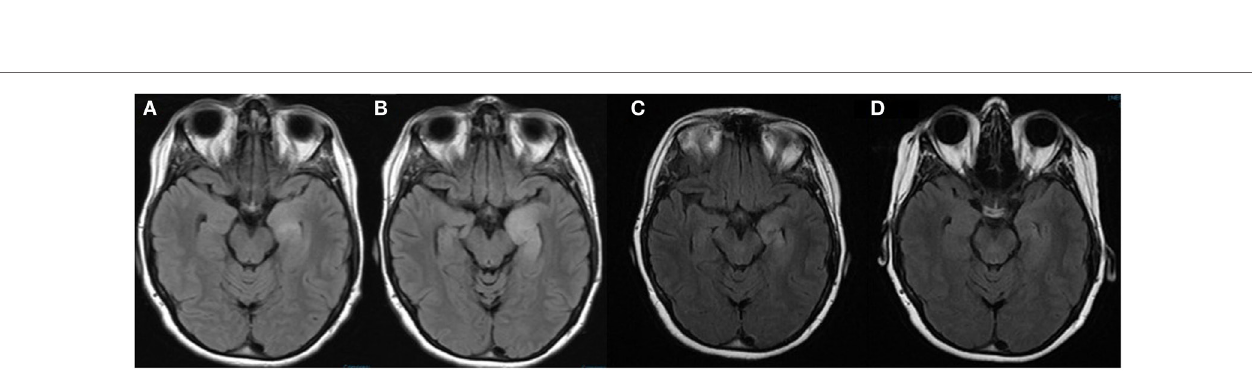
FIGURe 1 | MRI sequences from admission to the osH 2 days prior to admission at our hospital . These images demonstrate the cerebellar subacute infarction with no restricted diffusion, but contrast enhancement. These images remained unchanged 2 days later on admission to our hospital. (a) DWI, (B) T2, (C) T1 precontrast, and (D) T1